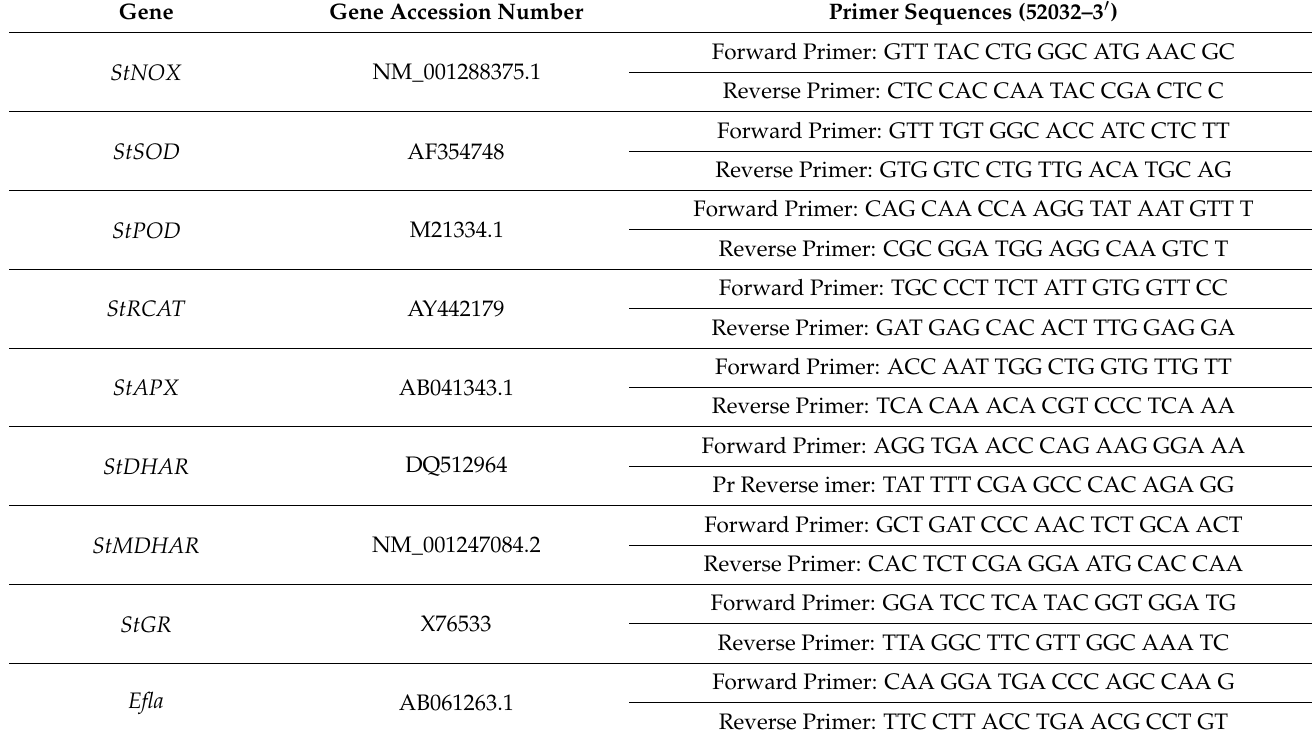
Table 1. List of primer sequences used for Quantitative Real-Time PCR